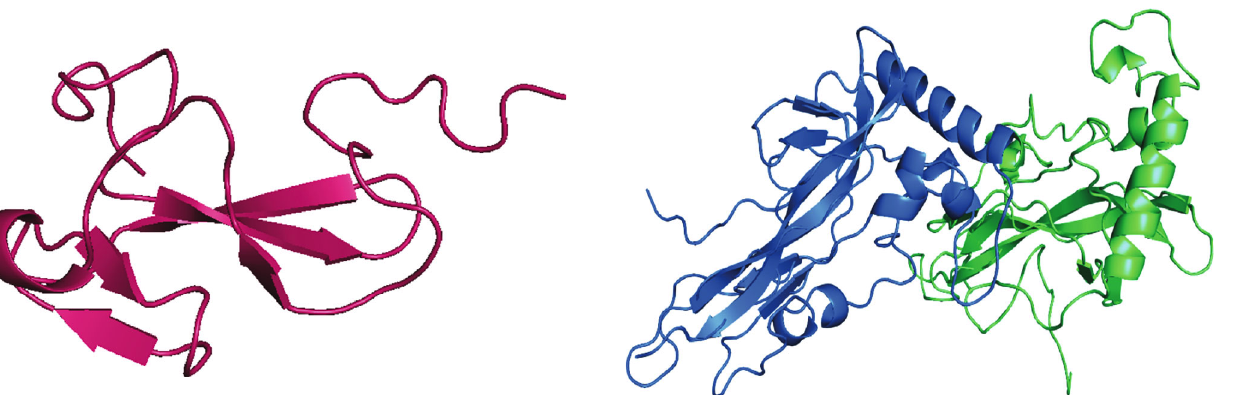
Figure 7: Solution structure of tachycitin, an antimicrobial protein with chitin-binding function of Tachypleus tridentatus (pdb id: 1DQC) [64].